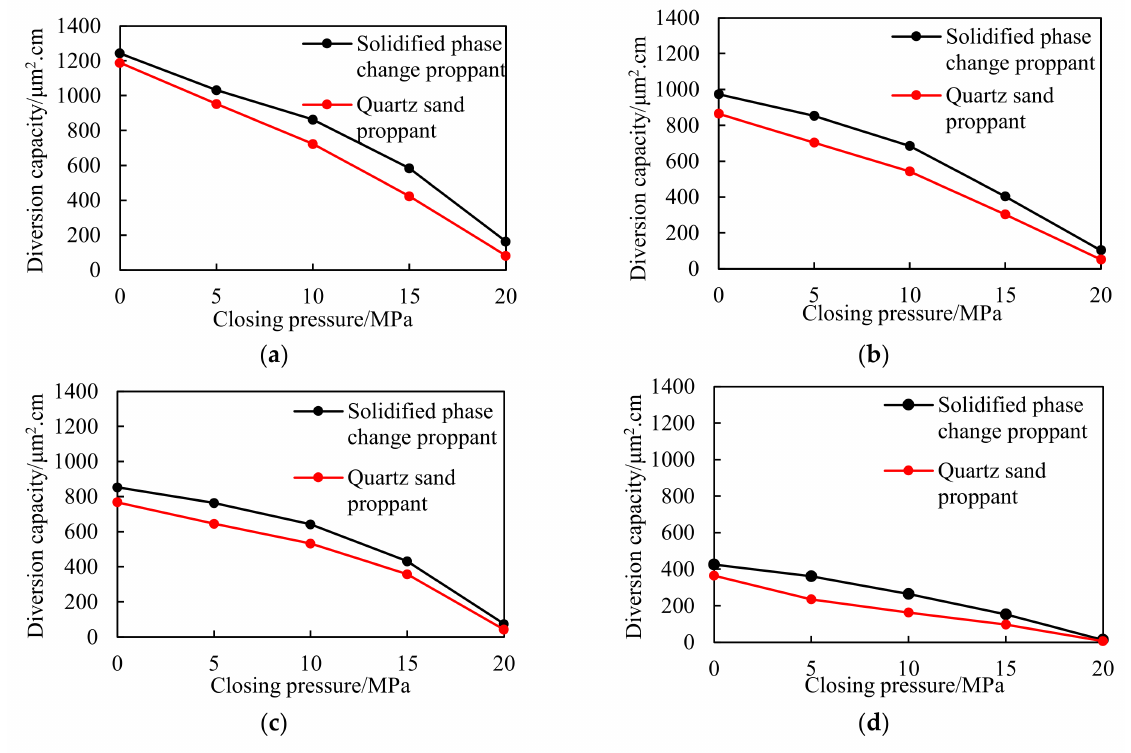
Figure 19. Evaluation results of diversion capacity of solidified phase change proppant and quartz sand proppant with the same particle size. (( a – d ) are the evaluation results of the diversion capacity of solidified phase change proppant and quartz sand proppant with particle sizes of 4.5 mm, 3 mm, 2–2.5 mm and 0.5 − 1 mm,